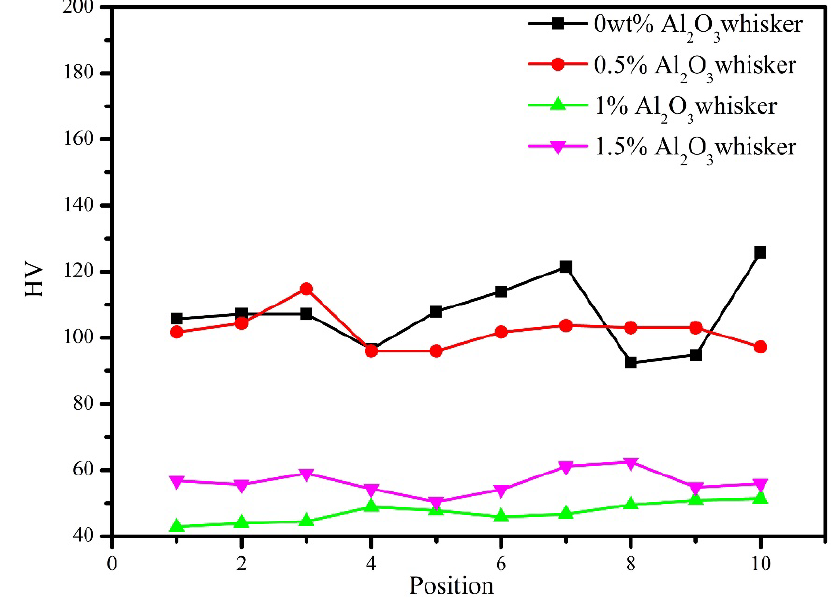
Figure 8. Micro-hardness of sintered composites with different content of alumina whiskers.